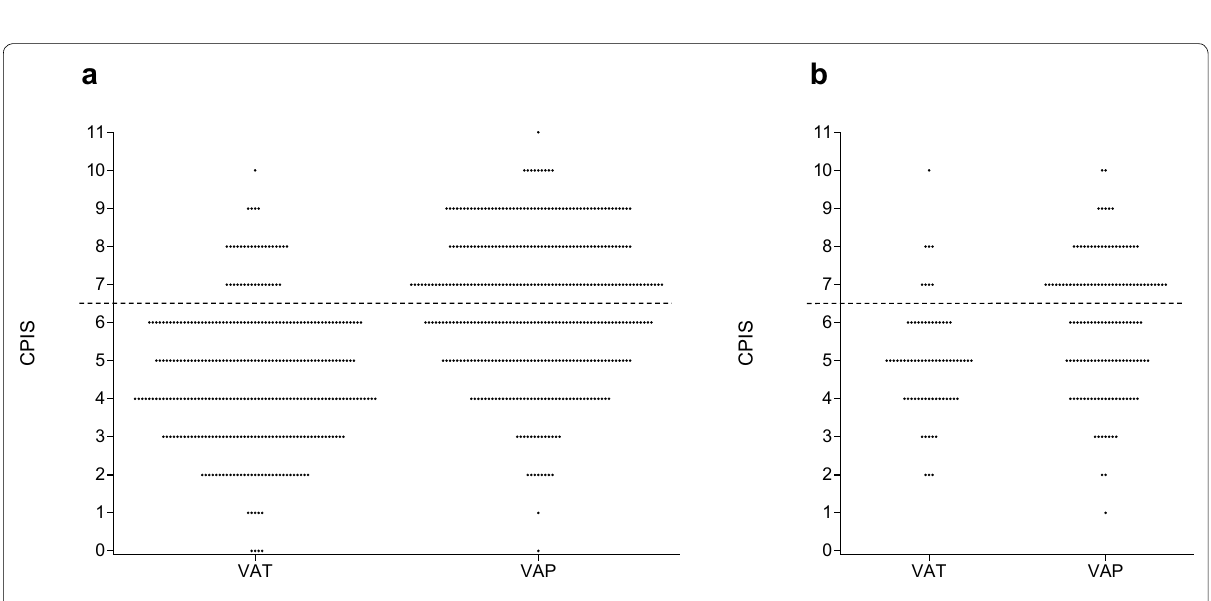
CPIS Clinical pulmonary infection score, Se Sensitivity, Sp Specificity, PPV Positive predictive value, NPV Negative predictive value, LR Negative likelihood ratio